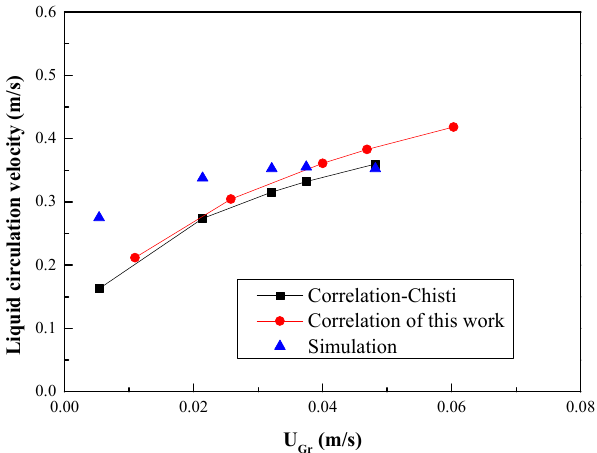
Figure 12. Comparison of liquid circulation velocity calculated from the correlations and CFD simulation with the U Gr .